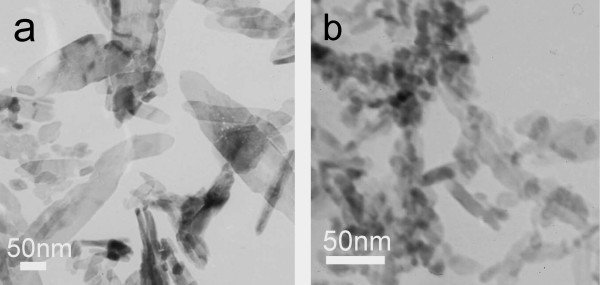
TEM images of CuO nanofluids prepared with different copper salts. (a) CuCl2·2H2O; (b) Cu(NO3)2·3H2O.